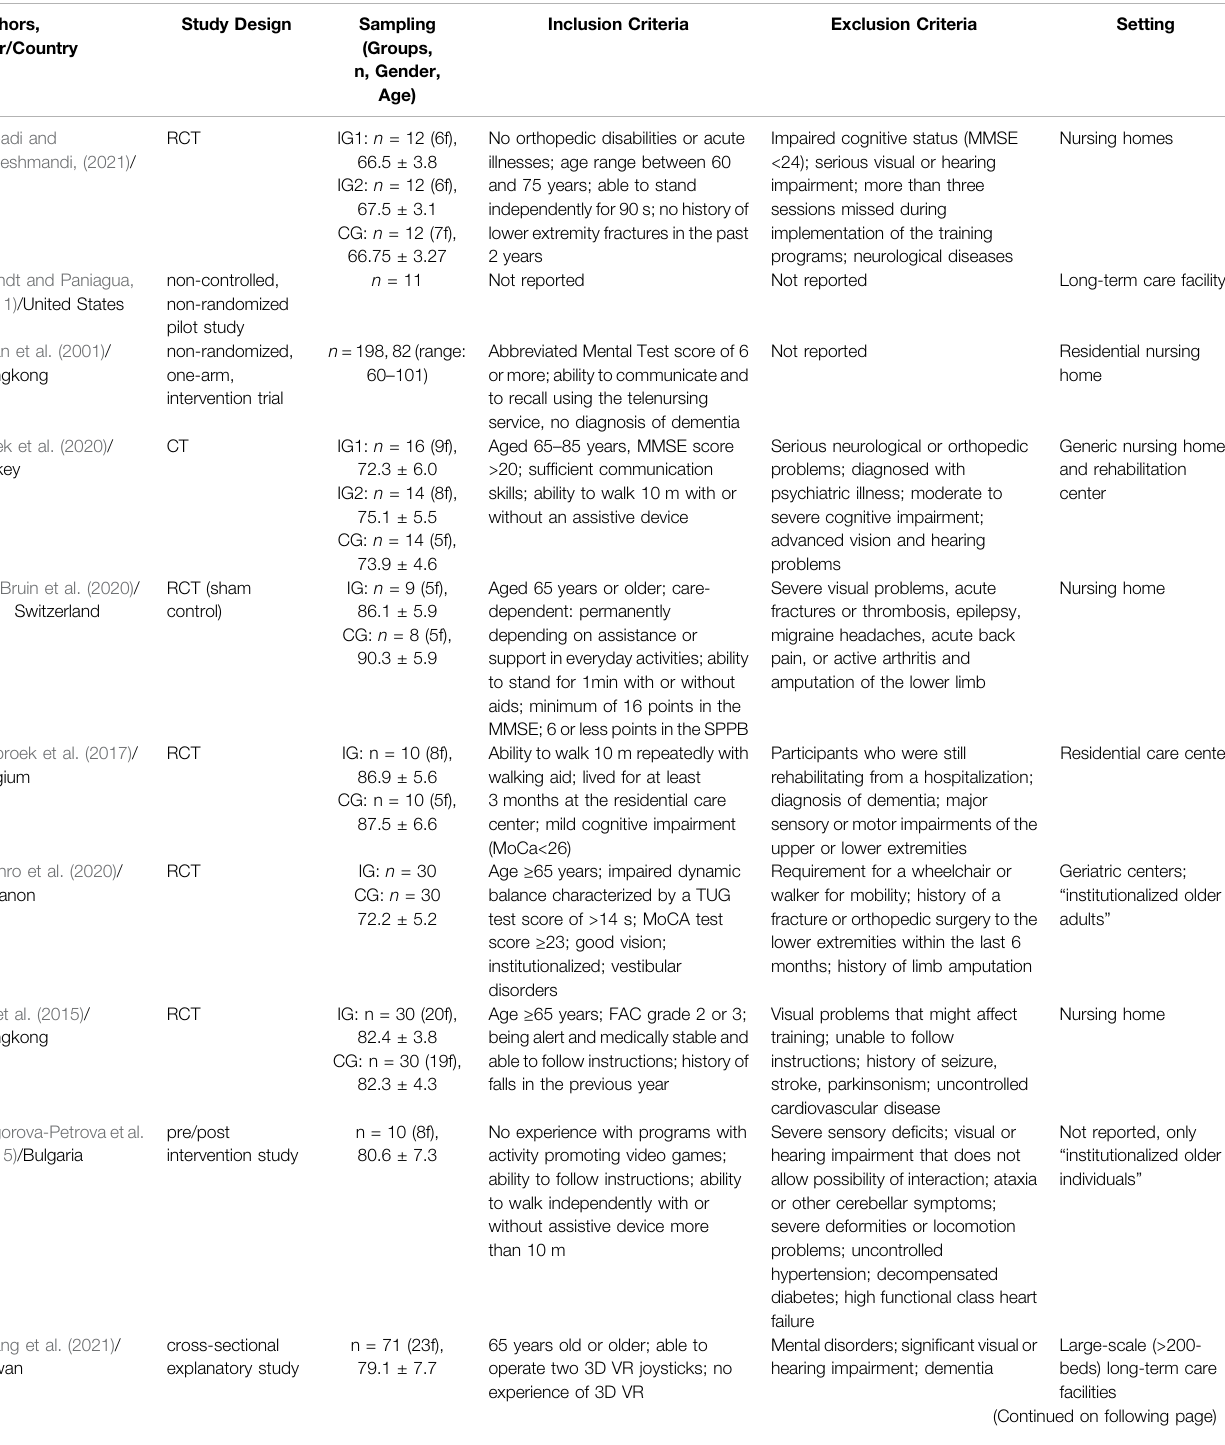
TABLE 2 | General information, study design, subject characteristics and setting of included